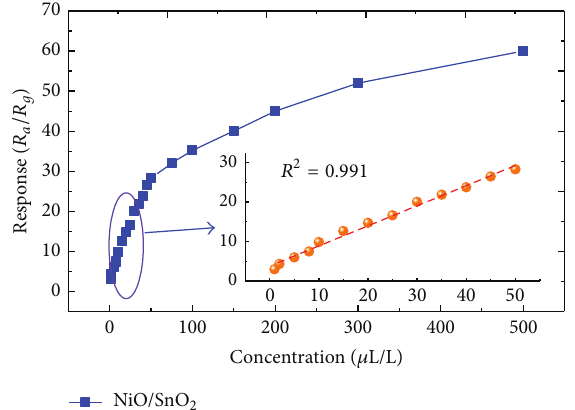
Figure 7: Gas responses of NiO/SnO 2 composites based sensor versusdifferentconcentrationofH 2 .Theinsetoneisthelinearfitting curve in the range of 1 to 50 𝜇 L/L.